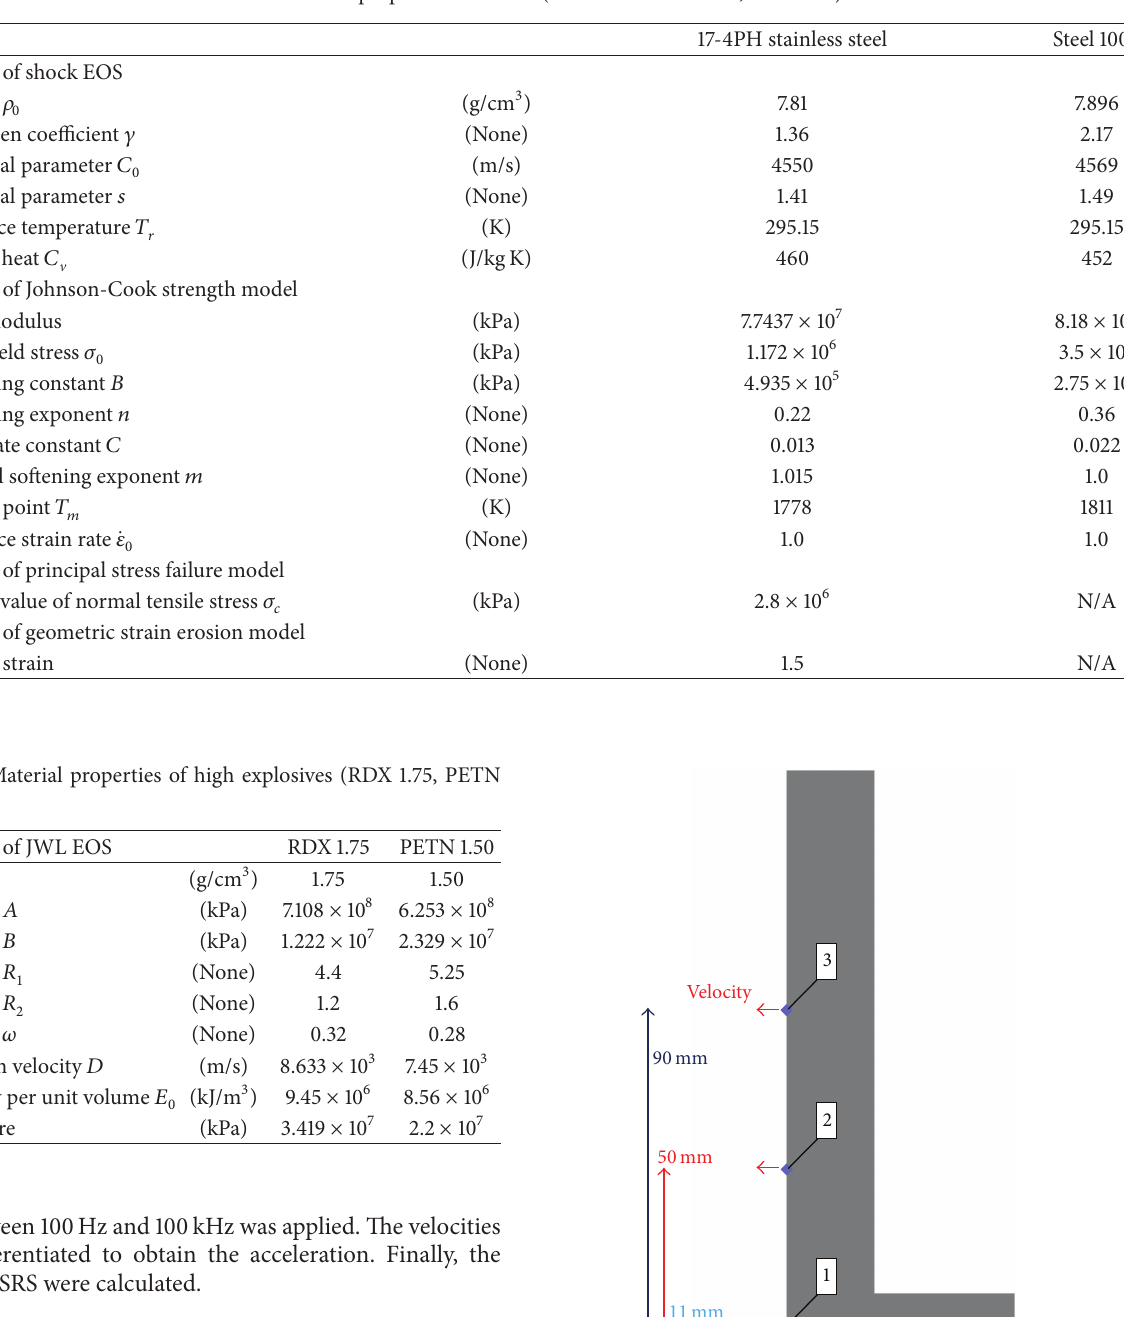
Table 1: Material properties of metals (17-4PH stainless steel, steel 1006).